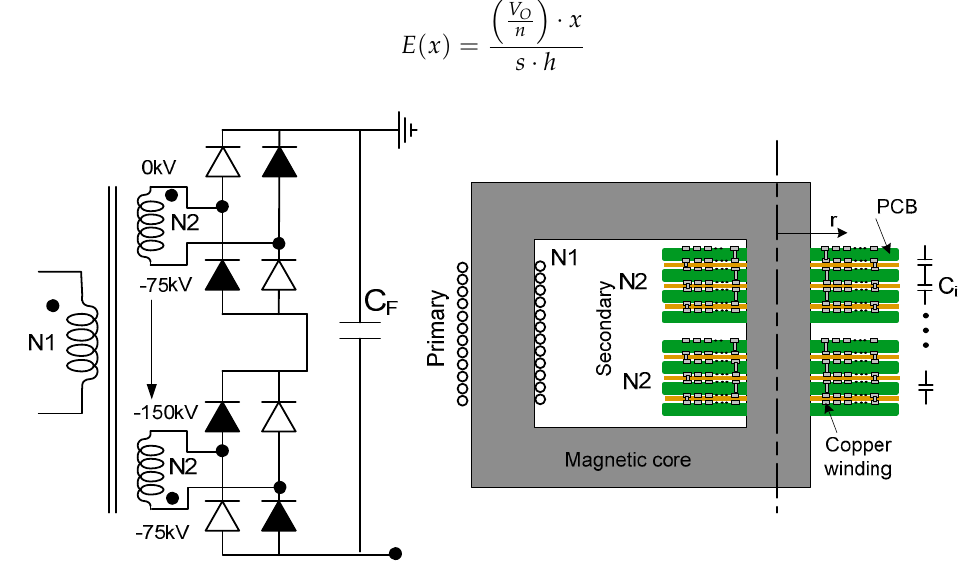
Figure 10. Cross section of the high-voltage transformer and external connection.